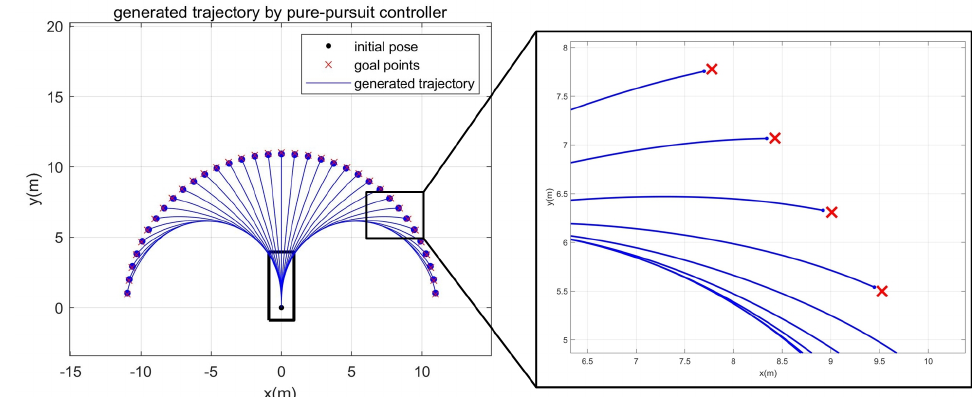
Figure 2. Trajectory generation results using Pure-pursuit